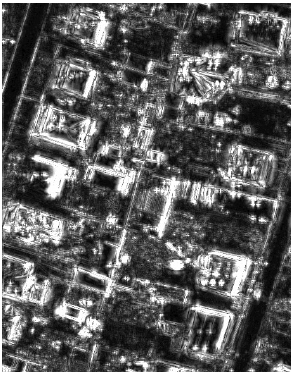
Figure 5. Example of a barrier image: black/white → low/high barriers locations (the input orthoimages are shown in Figure 6)